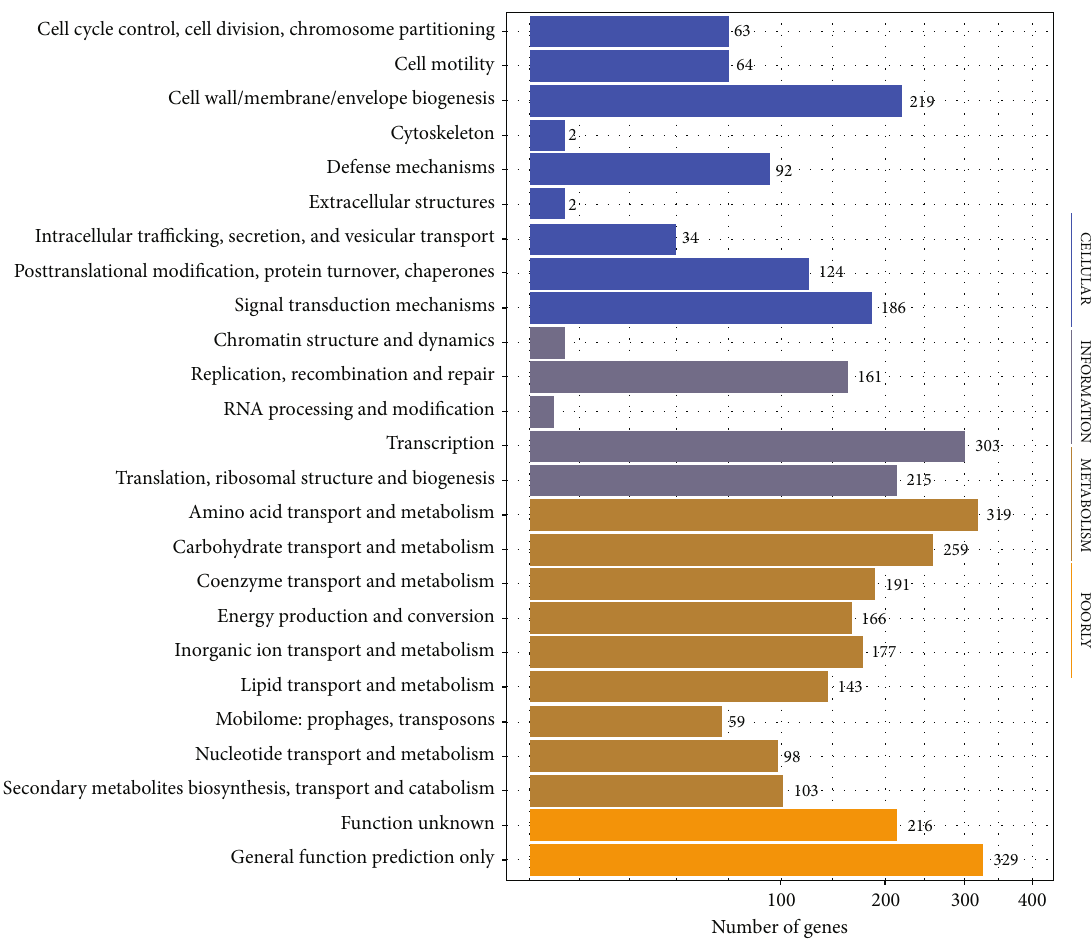
Figure 7: Annotation distribution map of COG functional